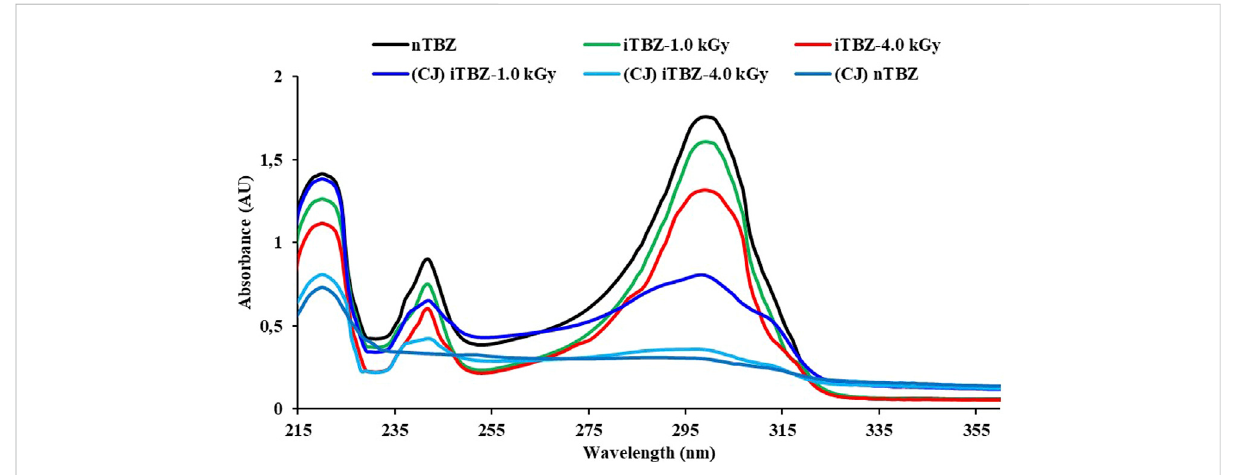
FIGURE 4 UV-visiblespectrumofnTBZ,iTBZ-1.0 kGyandiTBZ-4.0 kGybeforebioelectrochemicalexperimentsandnTB,iTBZ-1.0 kGyandiTBZ-4.0 kGy after bioelectrochemical experiments with CJ as